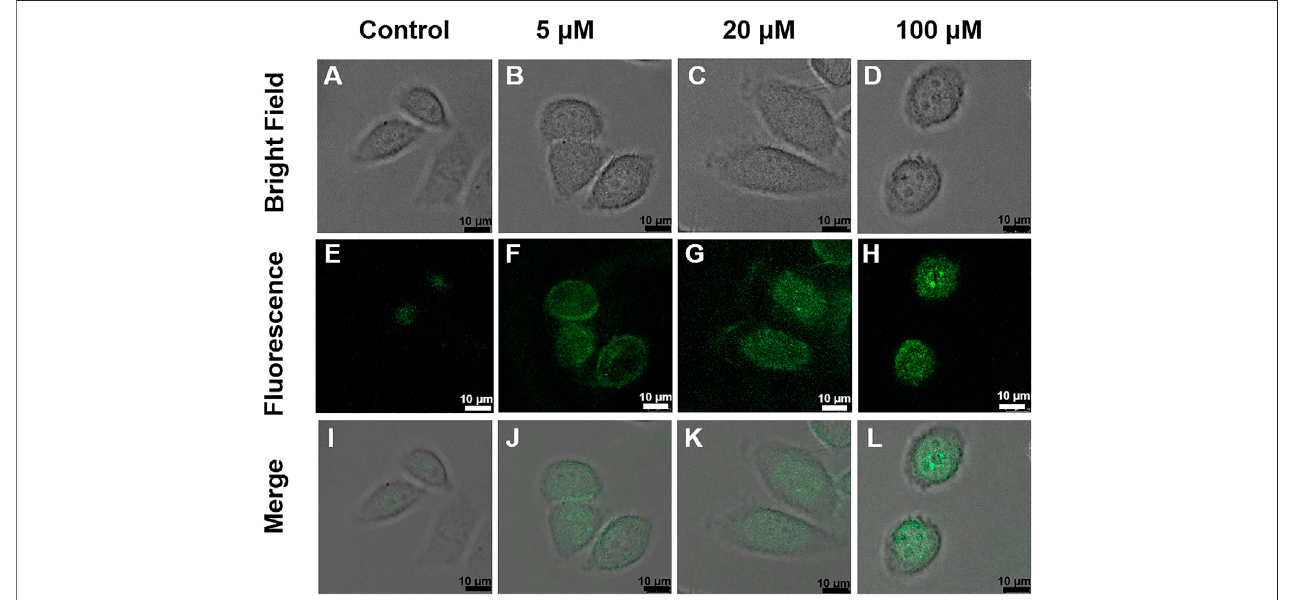
FIGURE7| Confocallaserscanningmicroscopy(CLSM)imagesofHeLacellstreatedwithDRF-PEG(0.1 mg/ml)anddifferentconcentrationsofFe 3+ (0,5,20,and 100 μ M). The upper panel: bright fi eld images, the middle: dark fi eld, and the lower: overlays of the bright and dark fi eld images. HeLa cells were fi rst incubated with DRF-PEG(0.1 mg/ml)for30 minandthenwithdifferentconcentrationsofFe 3+ as0 μ M (A,E,andI) ,5 μ M (B,F,andJ) ,20 μ M (C,G,andK) ,and100 μ M (D,H,andL) for another 30 min at 37 ° C.